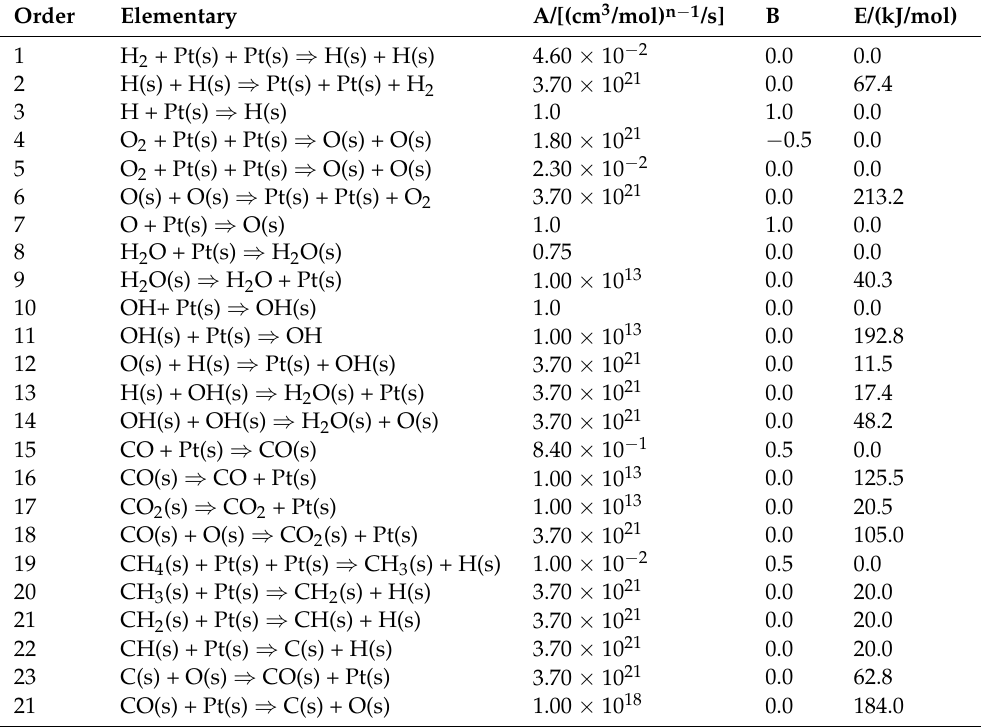
Table 1. The 24-step surface reaction mechanism of methane